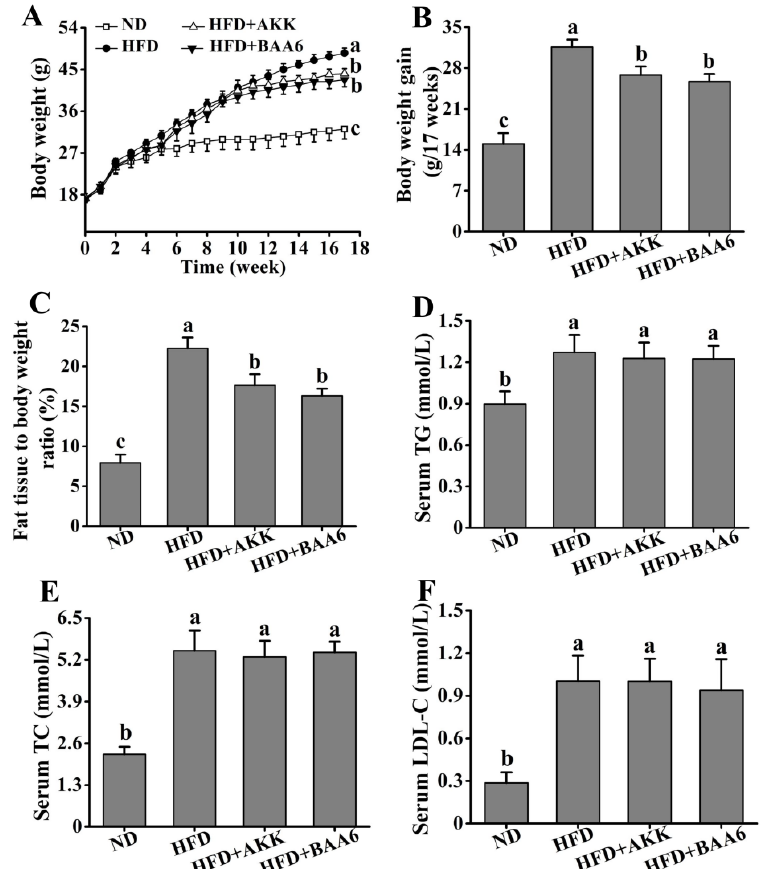
Figure 1. E ff ects of oral administration of Bifidobacterium animalis subsp. lactis A6 (BAA6) or Akkermansia muciniphila (AKK) on metabolic parameters in high-fat diet (HFD)-fed mice. ( A ) Body weight, ( B ) body weight gain, ( C ) relative adipose tissue, and serum levels of ( D ) total triglyceride (TG), ( E ) total cholesterol (TC), and ( F ) low-density lipoprotein cholesterol (LDL-C) following daily treatment with 10 9 colony-forming units (CFU) / kg of BAA6 or AKK. Values are expressed as means ± SD ( n = 6). Bars with di ff erent lowercase letters denote significant di ff erences among groups ( p < 0.05). HFD, fed high-fat diet for 17 weeks; HFD + BAA6, fed high-fat diet and treated with Bifidobacterium animalis subsp. lactis A6 for the final eight weeks; HFD + AKK, fed high-fat diet and treated with Akkermansia muciniphila for the final eight weeks; ND, fed normal diet for 17 weeks.